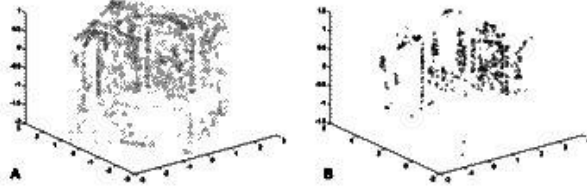
Figure 6: Distribution of the control and check points detected